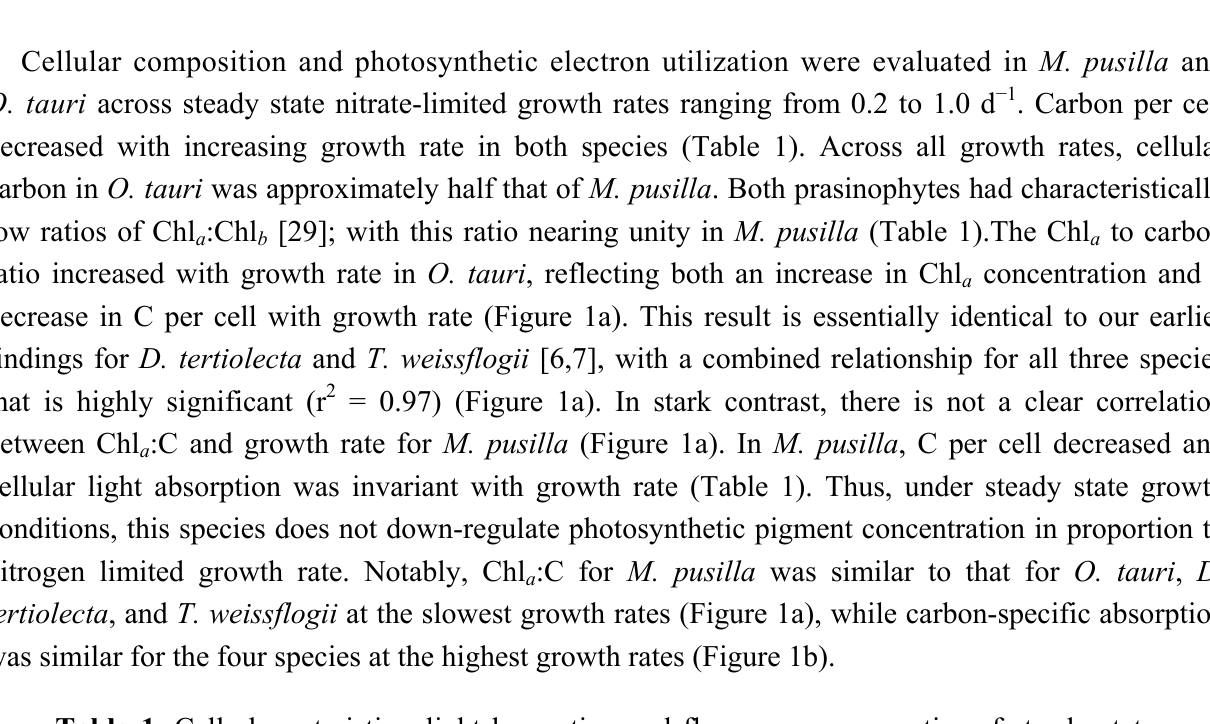
Table 1. Cell characteristics, light harvesting and fluorescence properties of steady state N-limited M. pusilla and O. tauri (values in parentheses are SE from triplicate cultures at each growth